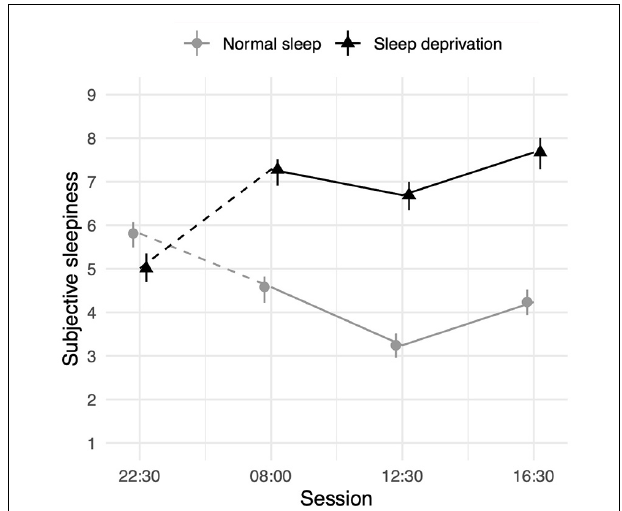
FIGURE 6 | Subjective sleepiness (1 = very alert, 9 = very sleepy) depending on sleep condition and time- of-day. Dots represent fixed-effect estimates and error bars represent bootstrapped confidence intervals with 100 iterations. The dotted line between 22:30 h and 08:00 h represents the night of total sleep deprivation for the sleep-deprivation group.